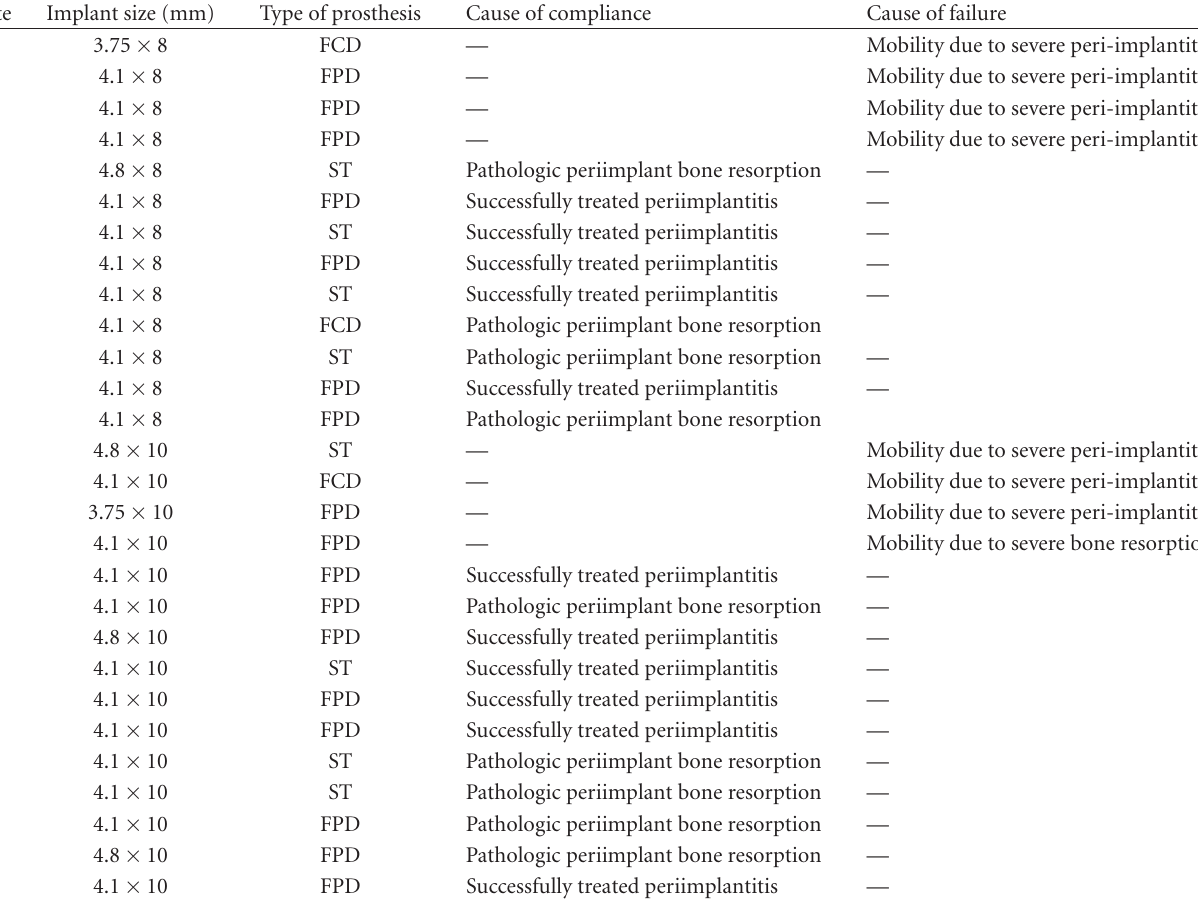
Table 4: Short and standard implants distribution: compliances and failures.